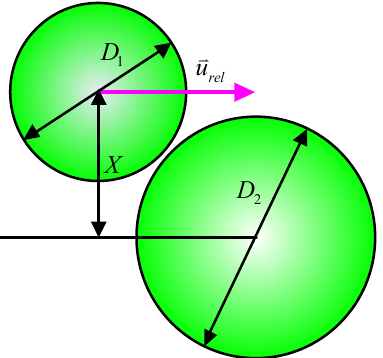
Figure 1. Schematic of binary droplet